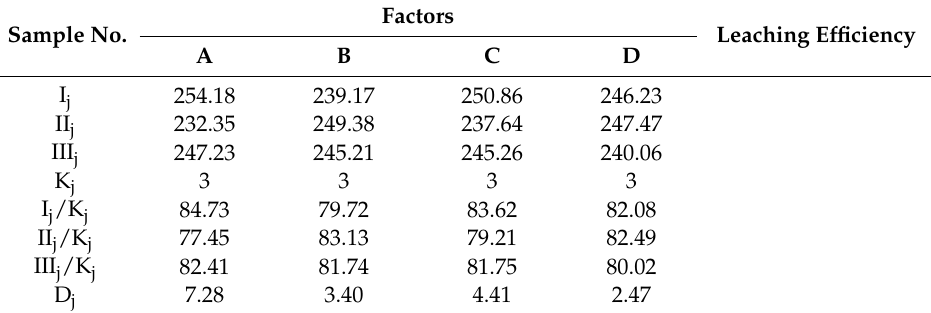
Table 5. L 9 (3 4 ) Orthogonal experiment design and acid leaching efficiencies of Ga (%).